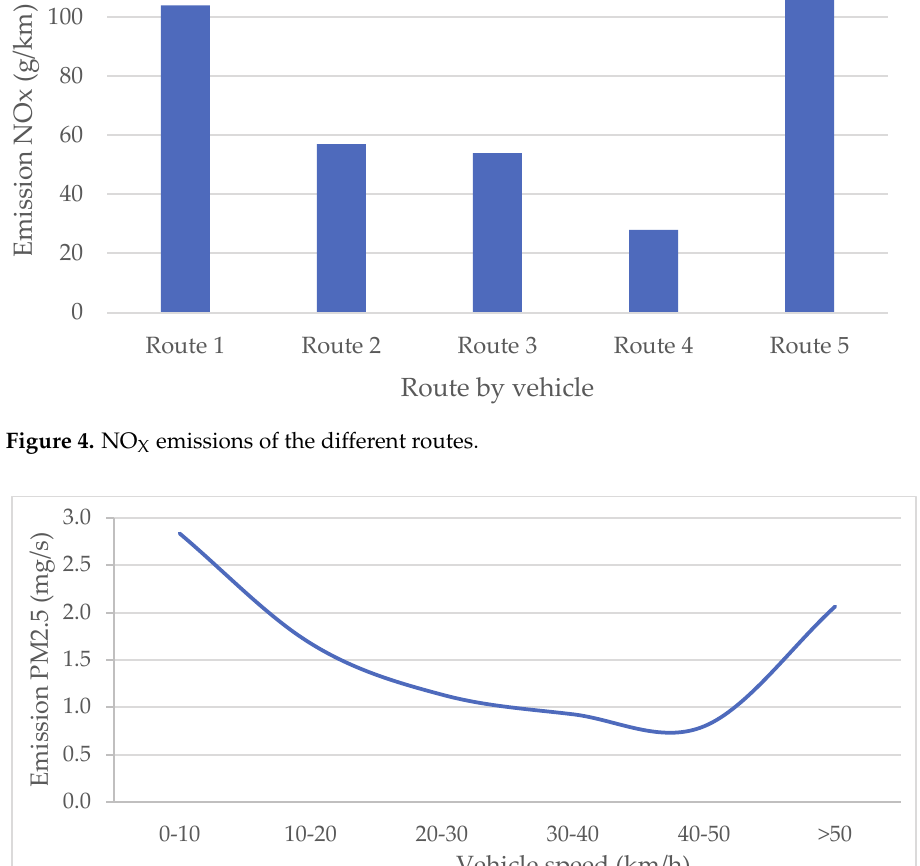
Figure 5. PM 2.5 Emission vs. Speed.